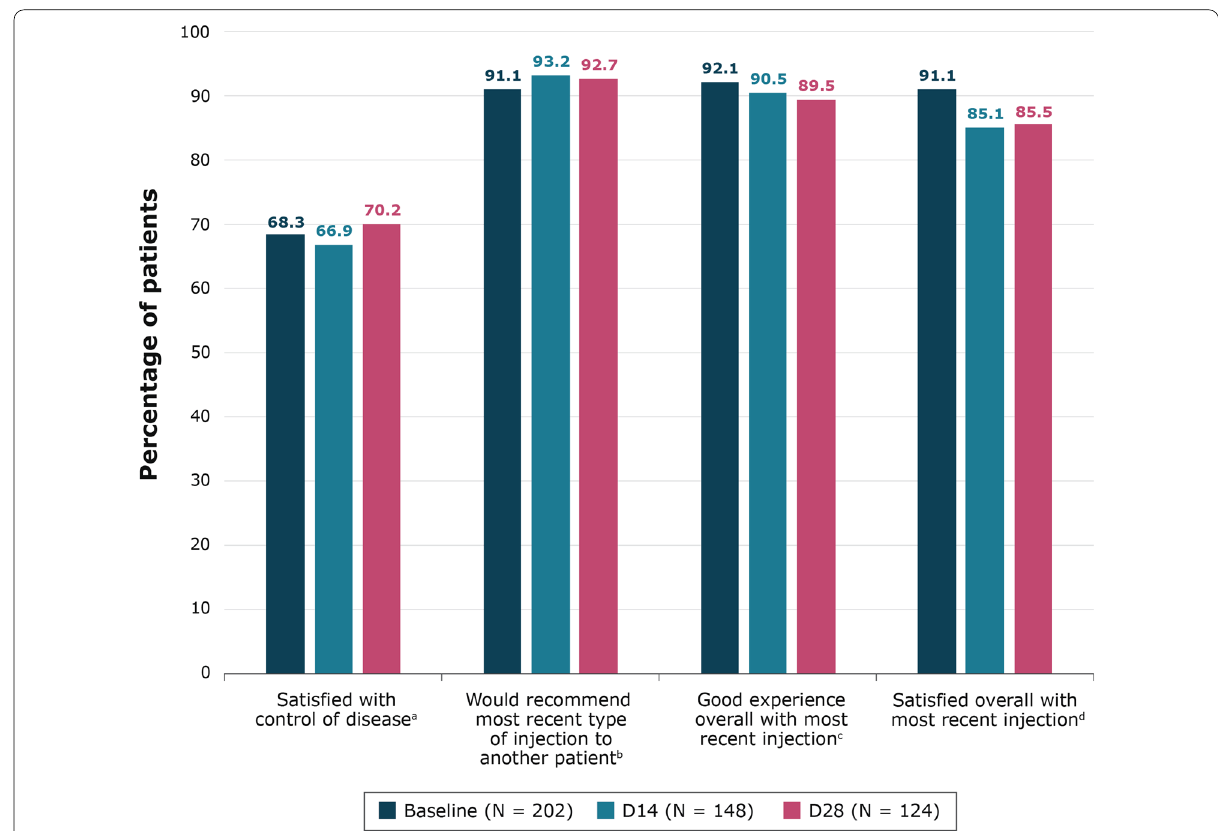
Fig. 2 Overall patient satisfaction with treatment at baseline, day 14, and day 28. a Includes responses of “Very satisfied” or “Somewhat satisfied”. b Includes response of “Definitely recommend” or “Probably recommend”. c Includes responses of “Very good experience” or “Good experience”. d Includes responses of “Very satisfied” or